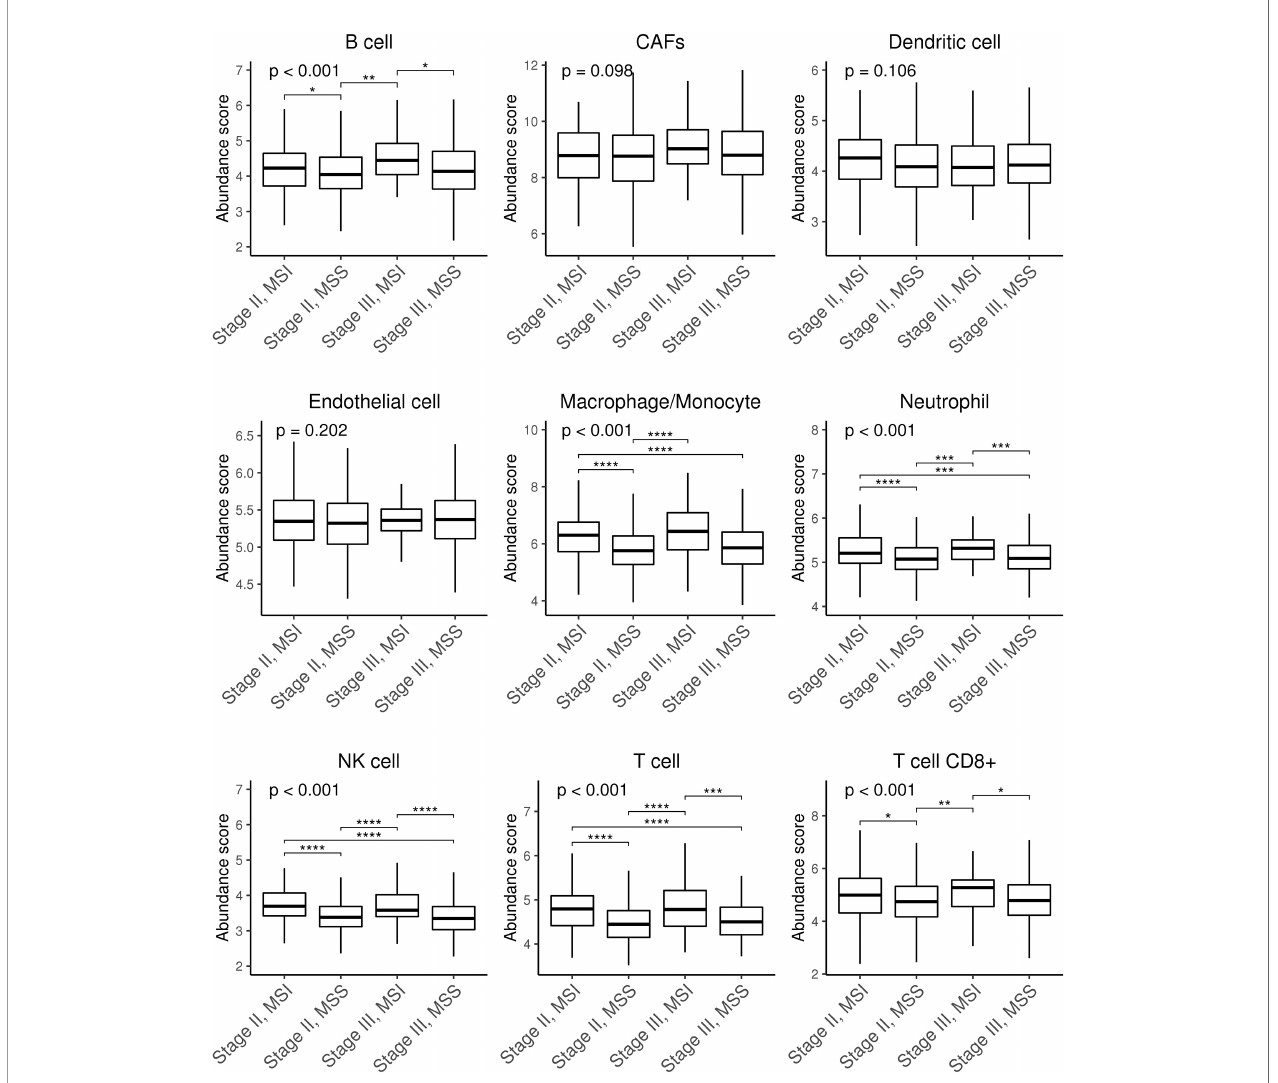
FIGURE 2 | Box plots showing stromal and immune in fi ltration across CRC patients strati fi ed by stage and MSS/MSI status. Stromal (CAFs and endothelial) and immune (B cells, dendritic cells, macrophages/monocytes, neutrophils, NK cells, T cells, and CD8 + T cells) in fi ltration scores were calculated using microenvironment cell populations-counter (MCP-counter) tool. Differences were assessed using non-parametric Kruskal – Wallis and Tukey ’ s tests (* p ≤ 0.05; ** p ≤ 0.01; *** p ≤ 0.001; **** p ≤ 0. 0001). CAFs, cancer-associated fi broblasts; NK, natural killer; CRC, colorectal cancer; MSS, microsatellite stable; MSI, microsatellite